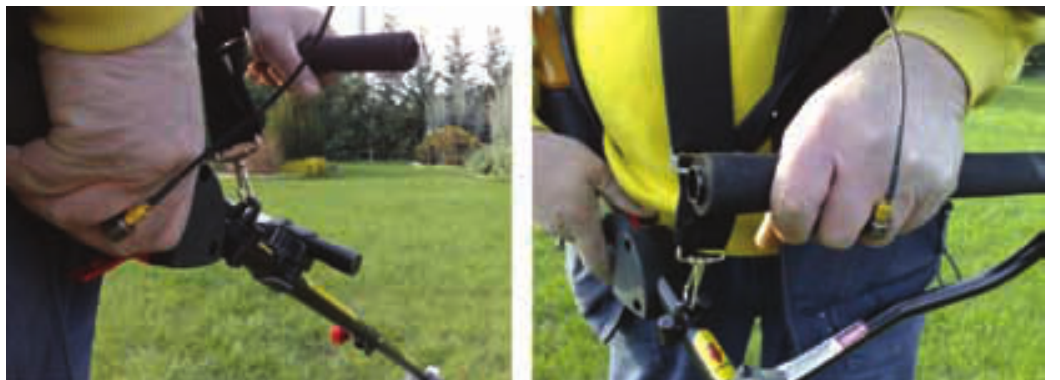
Figure 2. The position of the accelerometer at the back and at the front handle